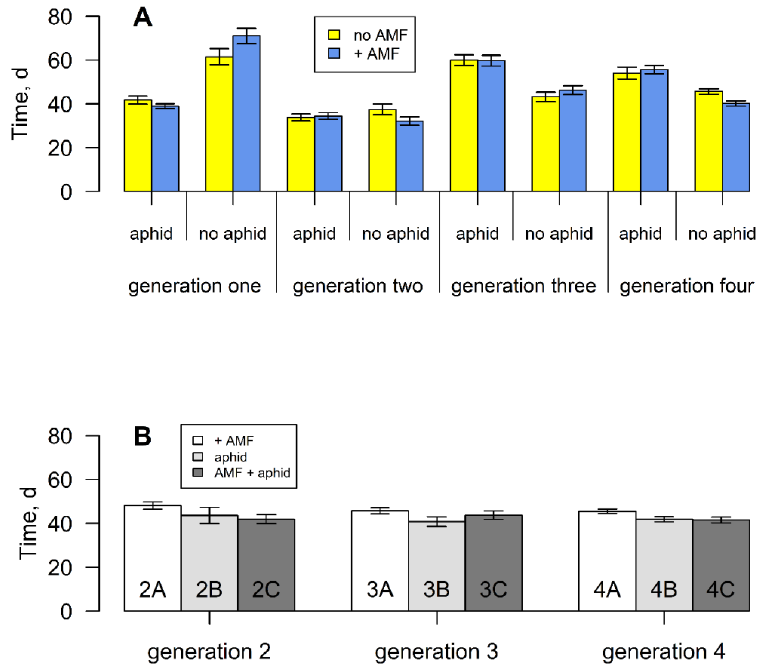
Figure 2. (A) Mean time to first flowering of S. vulgaris grown with or without arbuscular mycor- rhizal fungi and aphids for four successive generations. Vertical lines represent ± one standard